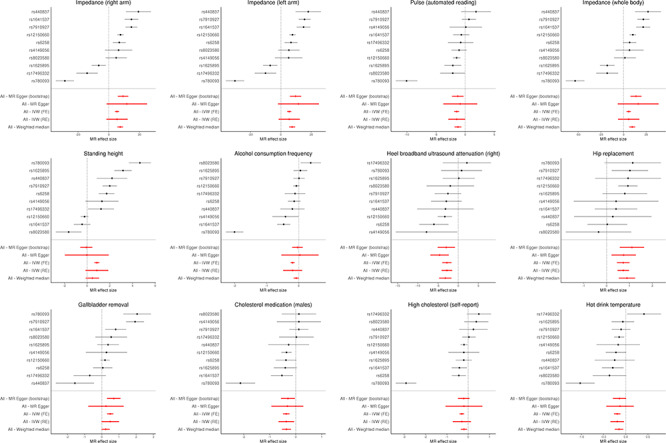
Forest plots of the two-sample MR results for phenotypes satisfying stringent correction for multiple testing (Bonferroni adjusted P-value <0.05) in the MR-pheWAS of SHBG, All-IVW (FE) = All-inverse variance weighted (fixed effects); All-IVW (RE) = All-inverse variance weighted (random effects). All MR effect sizes are per unit increase in natural log transformed SHBG (nmol/l). For phenotypes, impedance of right arm (units: ohms, field ID 23109), impedance of left arm (units: ohms, field ID 23110), pulse automated reading (units: beats-per-minute, field ID 102), impedance (whole body) (units: ohms, filed ID 23106), heel broadband ultrasound attenuation (right foot) (units dB/Mhz, field ID 4120), standing height (units: centimeters, field ID 50), alcohol consumption frequency (categorical intake, field ID 1558), hip replacement or revision (log odds, field ID 20004, value code #1318), gallbladder removal (cholecystectomy) (log odds, field ID 20004, value code #1455), cholesterol medication in males (log odds, field ID 6177, value code #1), self-report high cholesterol (log odds, field ID value 20002, code #1473) and hot drink temperature (categorical preference, field ID 1518).